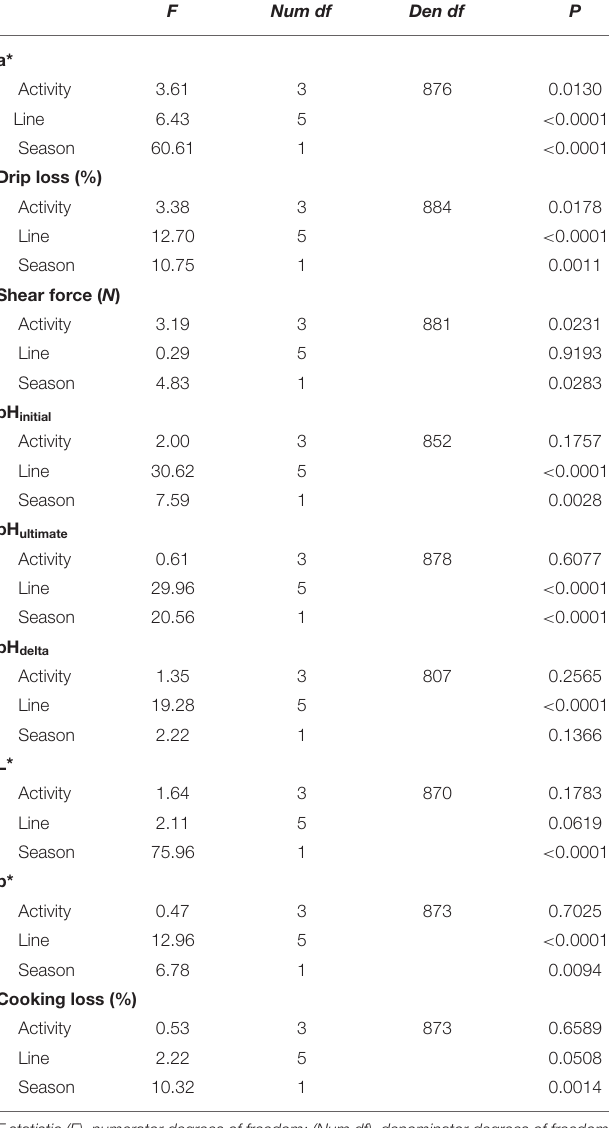
TABLE 4 | Differences in meat quality attributes between turkeys ( N Birds = 817–895 depending on the trait) with different post mortem activity scores 1–4. Trait 1 Activity